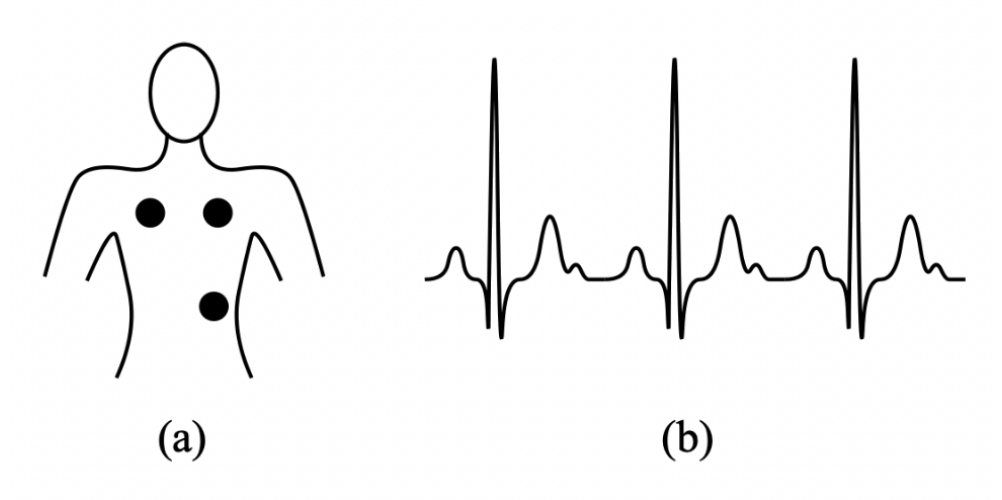
Figure 1. ( a ) Electrodes position for ECG recording ( b ) ideal ECG signal. The Electrocardiogram (ECG) is made up of three major segments that correspond to various cardiac operations: atrial depolarization (P wave), ventricular repolarization (T wave), and ventricular depolarization (QRS complex). There are three ECG feature types: hybrid, non-fiducial, and fiducial. Fiducial features retrieve discrete-time proper- ties from the Electrocardiography [4], which are calculated as time frames, pulse width, angles, and dynamical intervals based on the distinctive locations inside the ECG wave- form. Non-fiducial characteristics alter the feature points using transformation functions, whereas hybrid characteristics integrate fiducial and non-fiducial techniques.